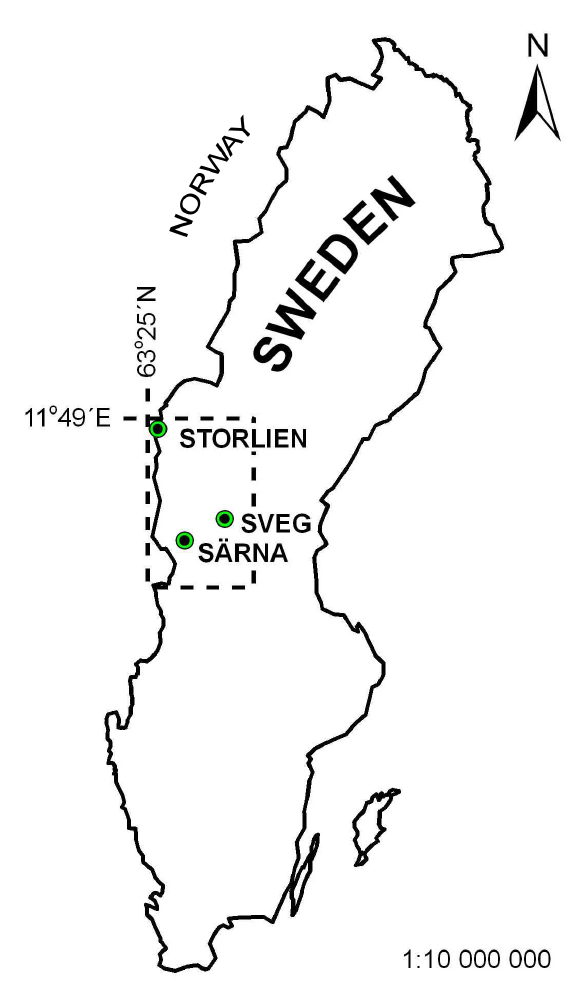
Figure 1: Map showing the study region in Mid-Central